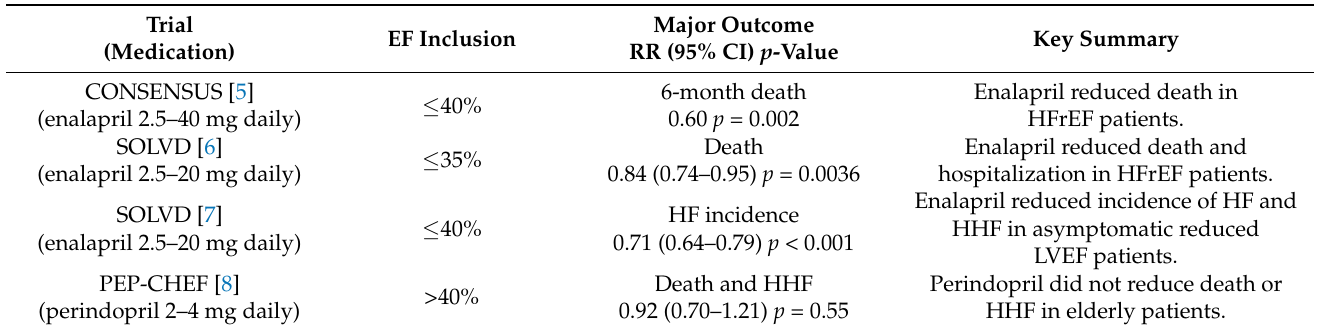
Table 1. Angiotensin-converting enzyme inhibitor heart failure trials.